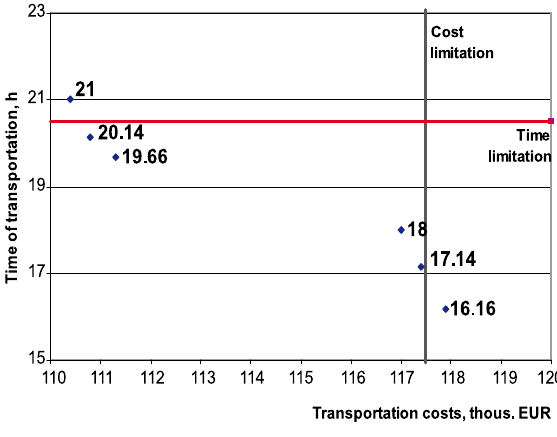
fig. 3. A graphical view of general